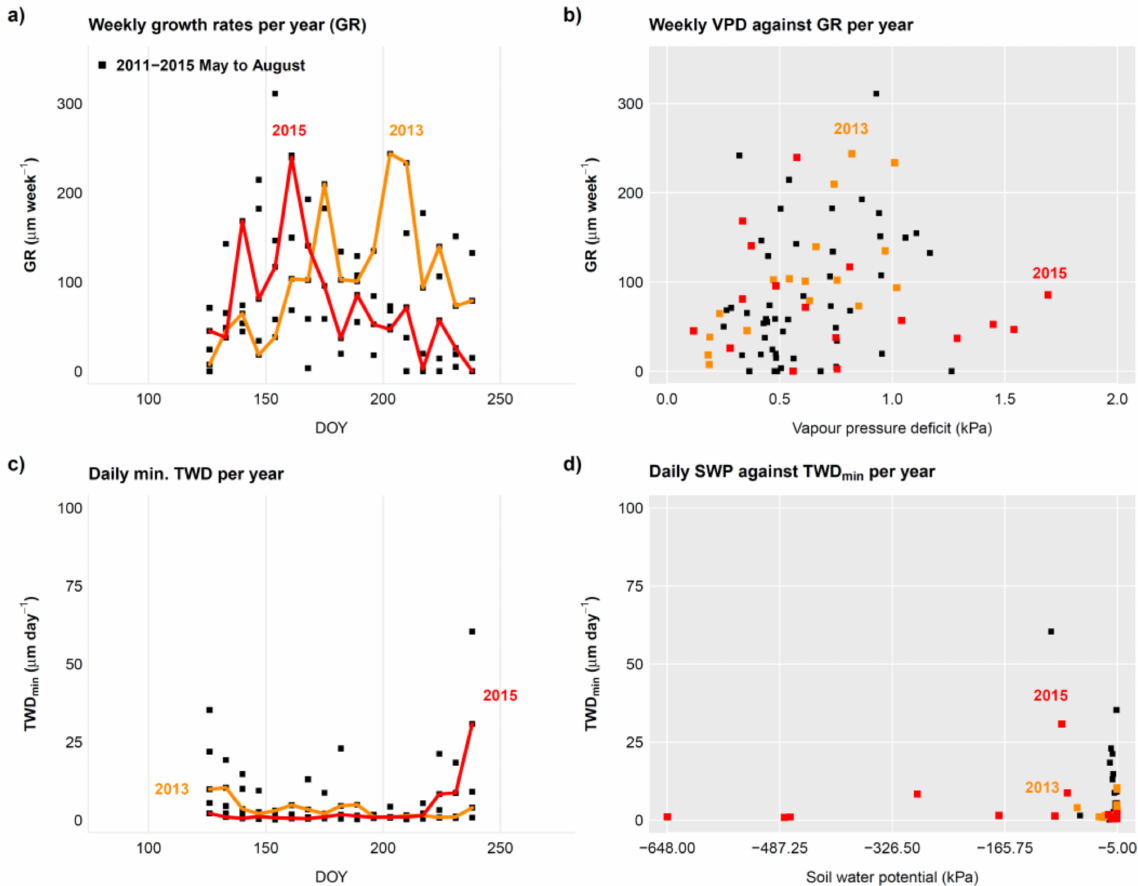
Figure 6. Example of seasonal tree physiological proxies extracted from stem radius data of a beech tree over five years at a 10 min resolution (as presented in Figure 5). ( a ) Weekly growth rates per year (GR) when isolating the main growing season (May-August). The year with the drought summer (2015) and the year with the highest growth rates in summer (2013) are coloured. ( b ) Response of GR (from a) to the mean weekly vapour pressure deficit (VPD). ( c ) Daily minimum tree water deficit (TWD min ) with the same years highlighted with colour as in a. ( d ) Response of TWD min to soil water potential with the same years highlighted with colour as in c. Note, these diagrams are not direct outputs of treenetproc and are solely intended as a possible representation of results relevant for